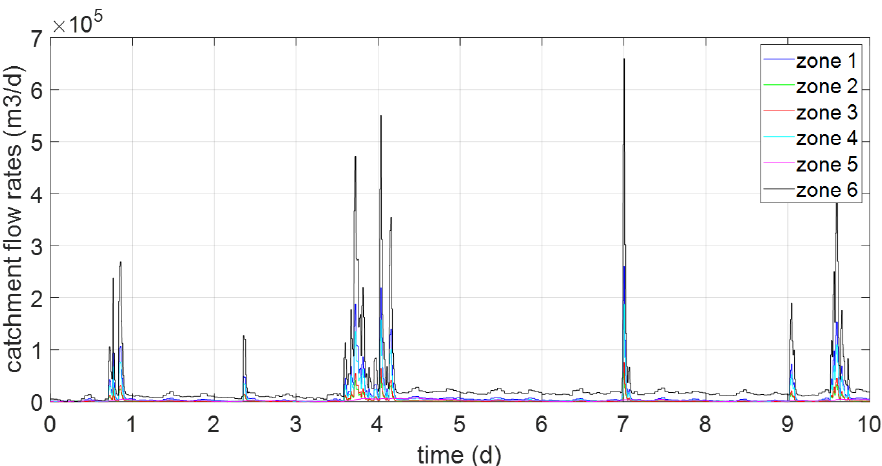
Figure 11. Scenario